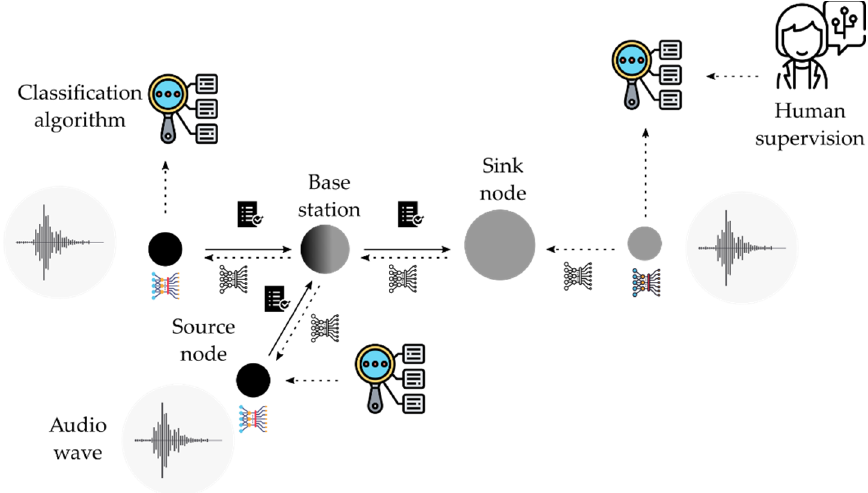
Figure 7. Cyber-Physical System Architecture.